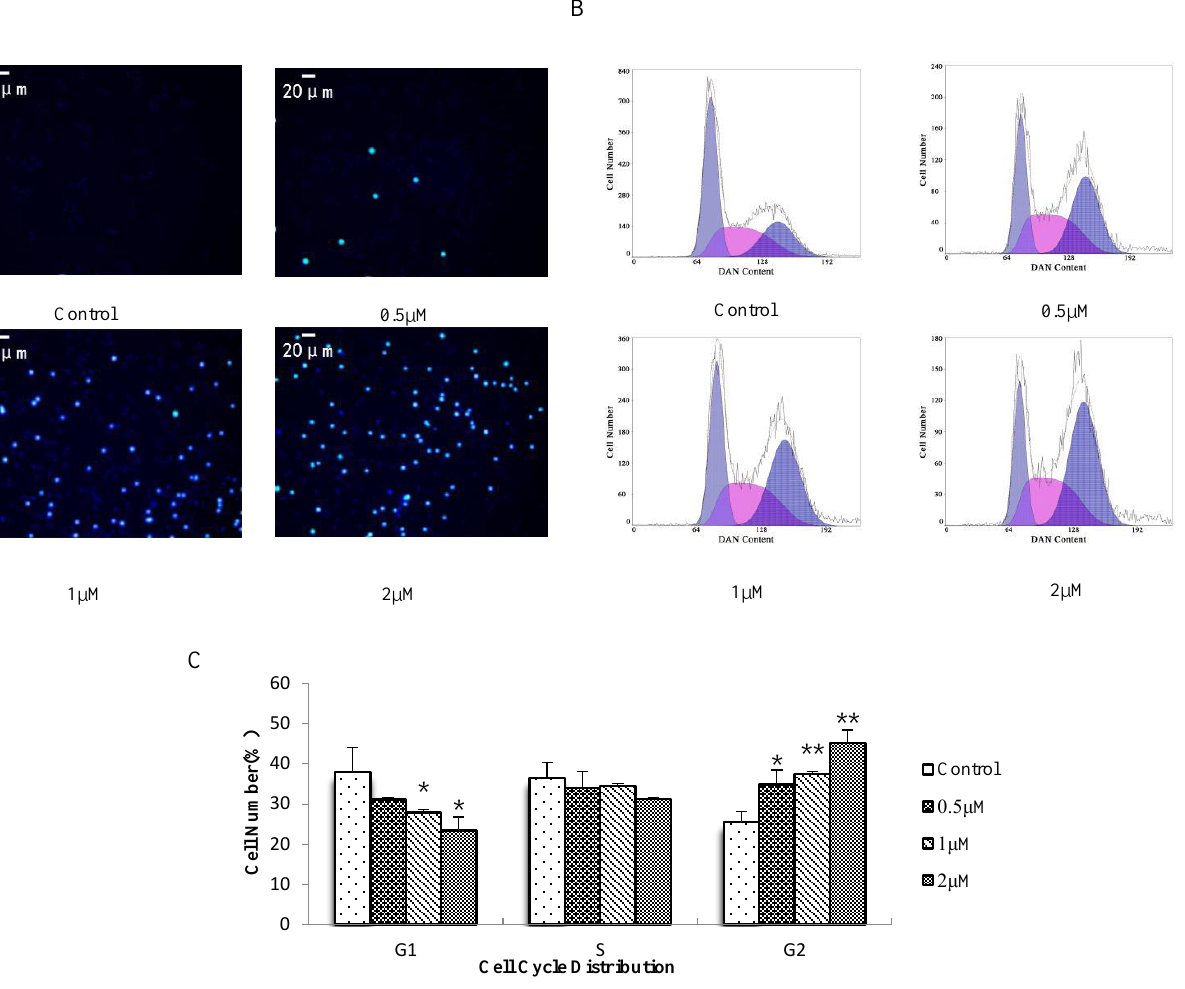
Figure 4. Analysis of cell fluorescence morphology and the cell cycle. ( A ) Fluorescence staining of nuclei in AO-treated and untreated cells using Hoechst 33342. ( B ) H8 cells were treated with different concentrations of AO and analyzed at 24 h by flow cytometry. ( C ) Percentage of cells in the indicated phases of cell cycle; (* p < 0.05, ** p < 0.01 ). SAA/OSR = 1:2 abbreviated as AO, which expressed the concentration of SAA as the concentration of AO, for example, 1 μM AO is 1 μM SAA plus 2 μM OSR.